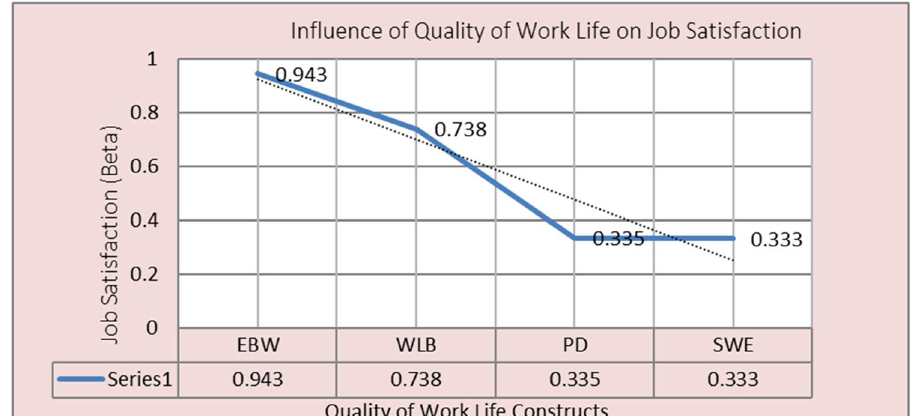
Fig. 3 Cumulative influence of Quality of Work Life on Job